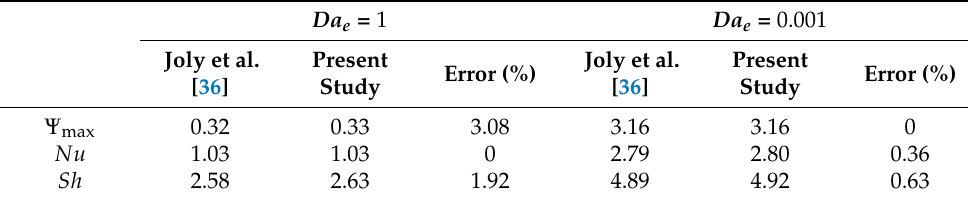
Table 2. Comparison of the present computed values of Ψ max , Nu , and Sh with a past study of numerical results for A = 8, R T = 150, N = − 1, Le = 10, and D u = 0 and S r = − 1. Da e = 1 Da e = 0.001 Joly et al. Present Joly et al. Present Error (%) Error (%) [36] Study [36] Study Ψ max 0.32 0.33 3.08 3.16 3.16 0 Nu 1.03 1.03 0 2.79 2.80 0.36 Sh 2.58 2.63 1.92 4.89 4.92